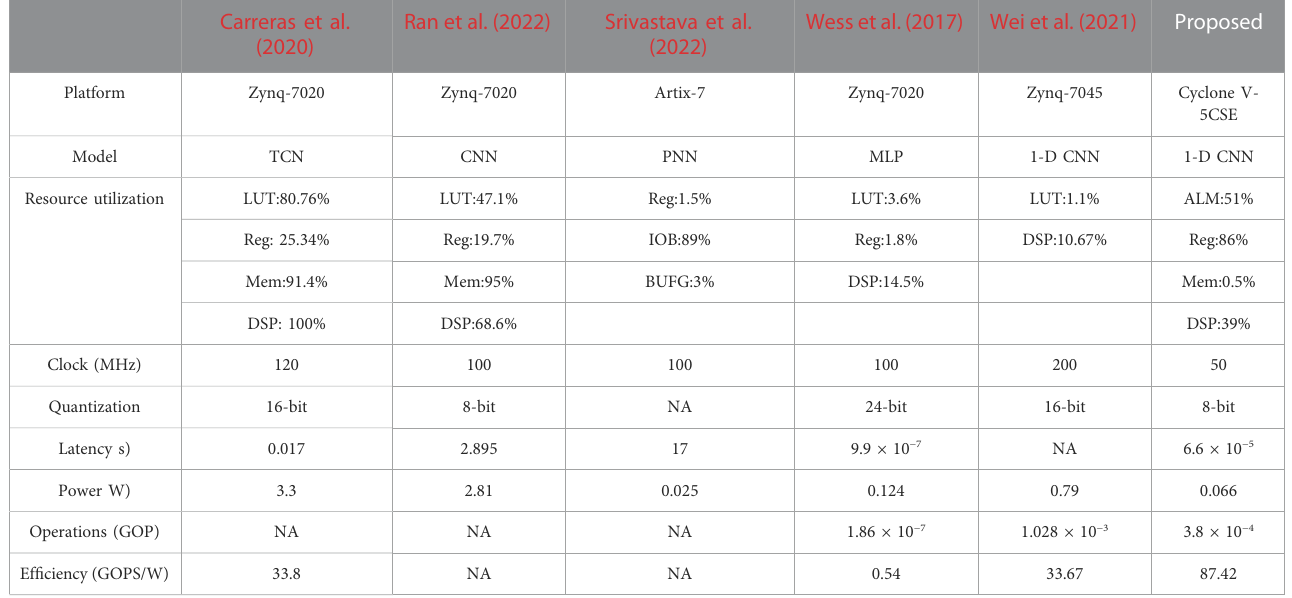
TABLE 3 Comparison with existing FPGA accelerators about ECG classi fi cation. Carreras et al.